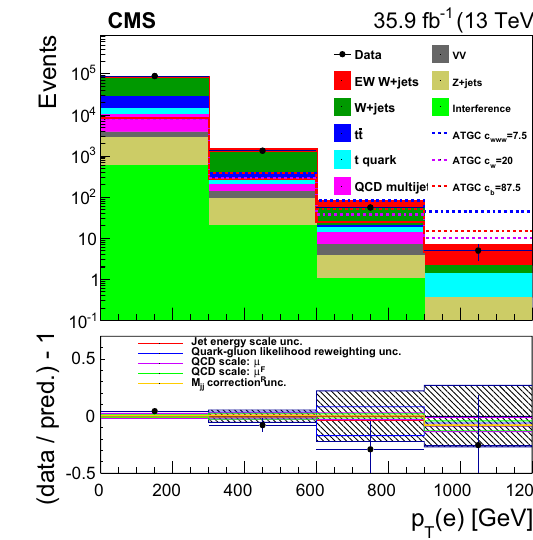
Fig. 10 Distributions of p (cid:2) in data and SM backgrounds, and various T ATGC scenarios in the muon (left) and electron (right) channels, before the fit. For each ATGC scenario plotted a particular parameter is varied while the other ATGC parameters are fixed to zero. The lower panels